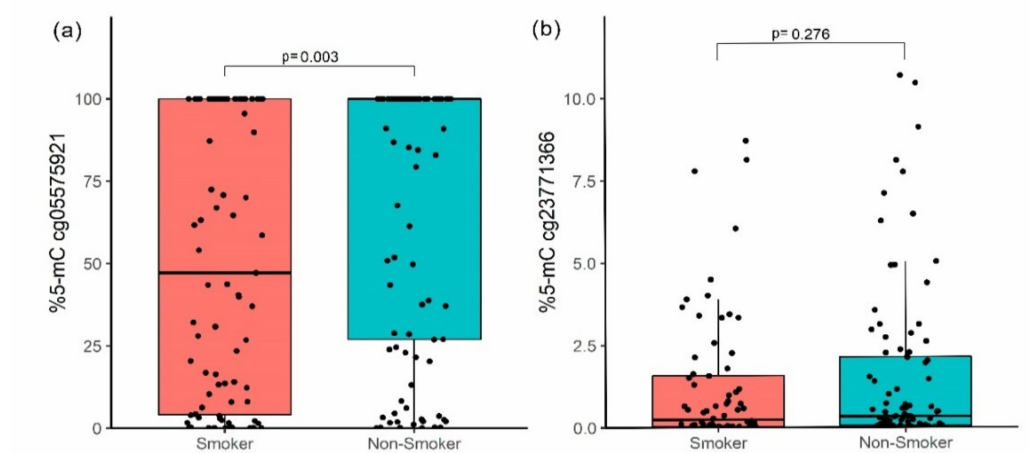
Figure 2. Methylation percentage between smokers and non-smokers. ( a ) cg05575921 ( AHRR ) site and ( b ) cg23771366 ( PRSS23 ) site; the p -value was obtained by the Mann–Whitney U test with a Bonferroni post-hoc